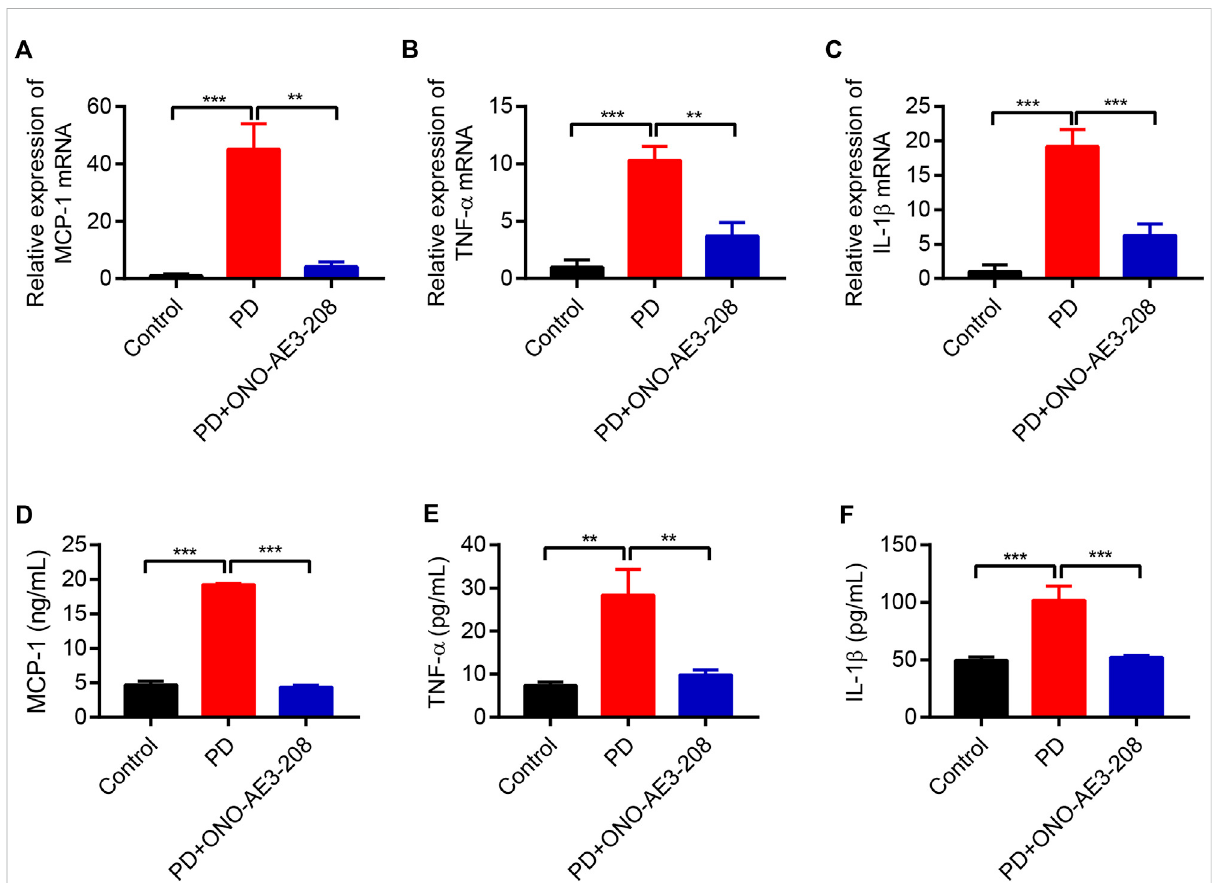
FIGURE 5 Administration of ONO-AE3-208 prevented in fl ammation in a rat model of peritoneal fi brosis. (A – C) Real-time quantitative PCR analysis of MCP-1, TNF- α , and IL-1 β levels in the visceral peritoneum for each animal group. (D – F) ELISA results of the secretion of MCP-1, TNF- α , and IL-1 β in the dialysate for each group. Data are presented as mean ± SEM. ** p < 0.01, *** p <